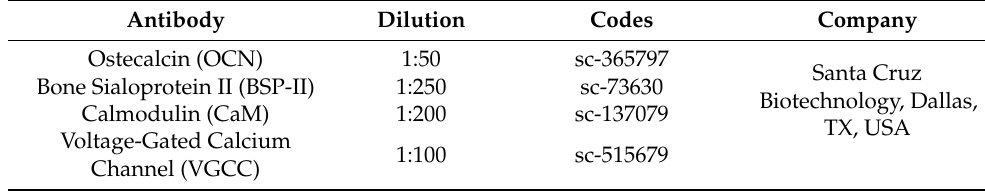
Table 2. Antibodies used for